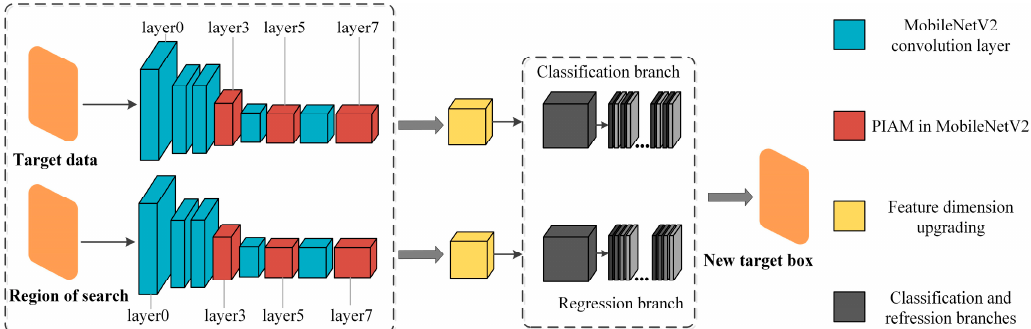
Figure 2. Fast dynamic dim target tracking approach.